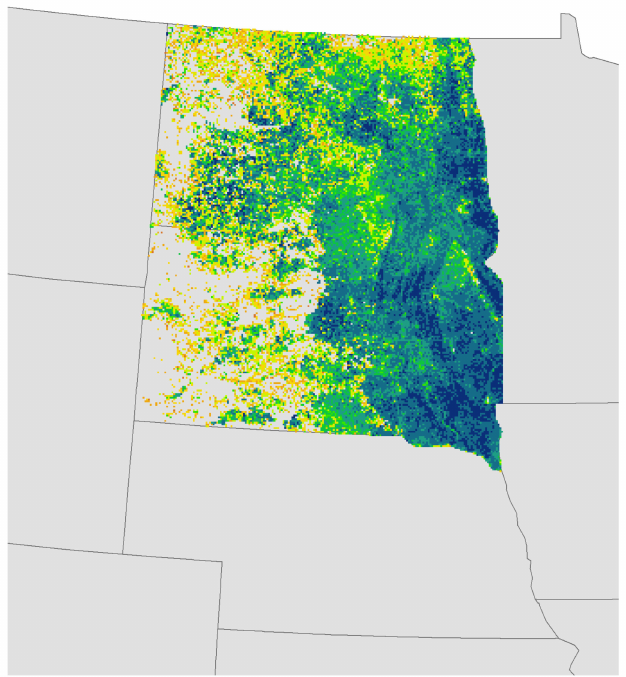
Figure A2. Confidence of pixels mapped as corn in the 2012 CDL. Within a specific state, there can be large spatial variation in the degree of certainty with which specific crops are mapped. In South Dakota and North Dakota, corn is mapped more confidently in the eastern parts of the states (dark blue), where the crop is more prevalent, and is mapped less confidently (green to yellow) as one moves westward and the crop becomes less